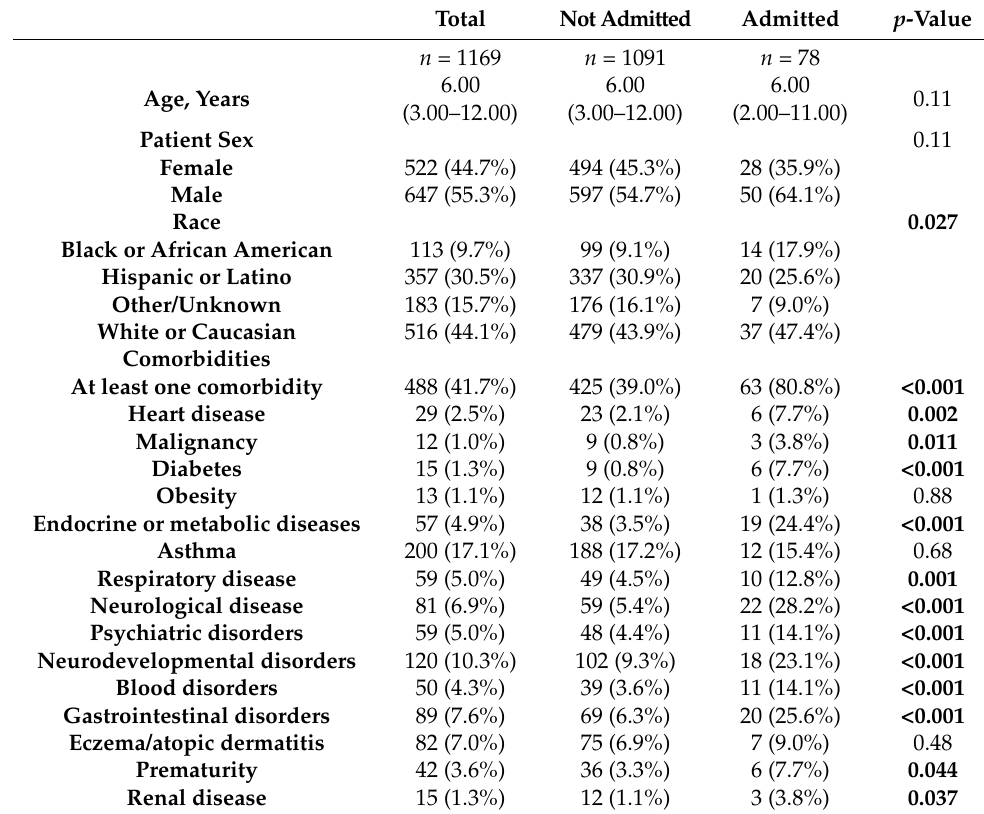
Table 1. Characteristics of children with lab-confirmed